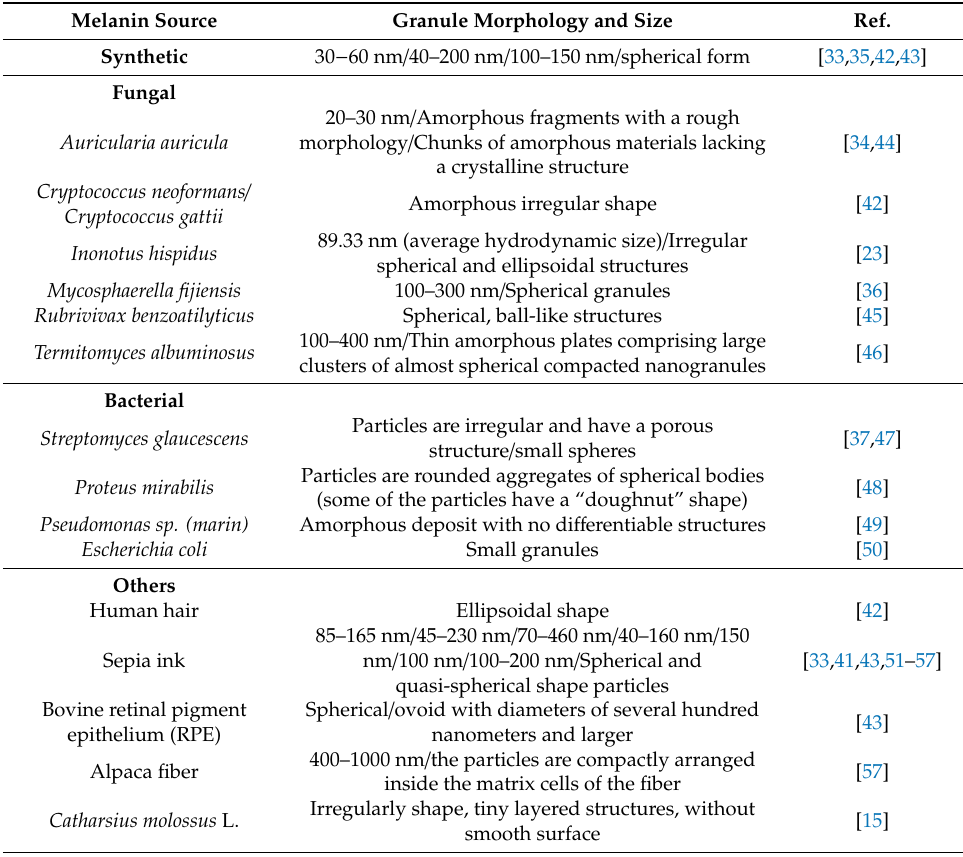
Table 3. SEM analysis of di ff erent types of